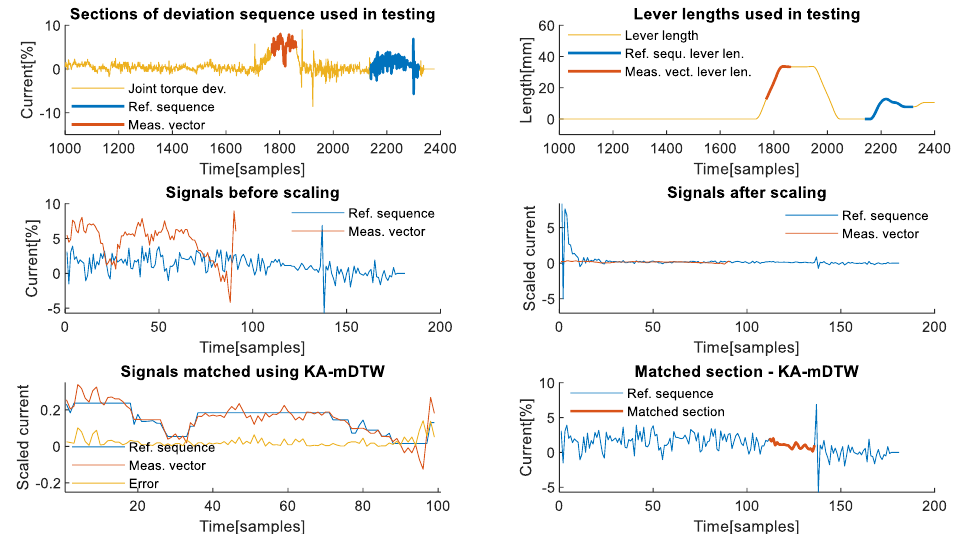
Figure 6. Analysis of example from the 4th axis. ( Upper left ) Deviation signal throughout the task with sections of the deviation signal used as reference sequence and the measurement vector. ( Upper right ) Sections of the lever lengths corresponding to the chosen reference sequence and the chosen measurement vector. ( Middle left ) Signal used as reference sequence and measurement vector in their original values prior to scaling by the algorithm. ( Middle right ) Signals used as reference sequence and measurement vector after scaling was applied. ( Lower left ) Graph shows optimally matched section of the reference sequence and the entire measurement vector as well as the sample-wise matching error. ( Lower right ) Reference sequence profile with the highlighted section, which was correctly interpreted and optimally matched with the measurement vector.